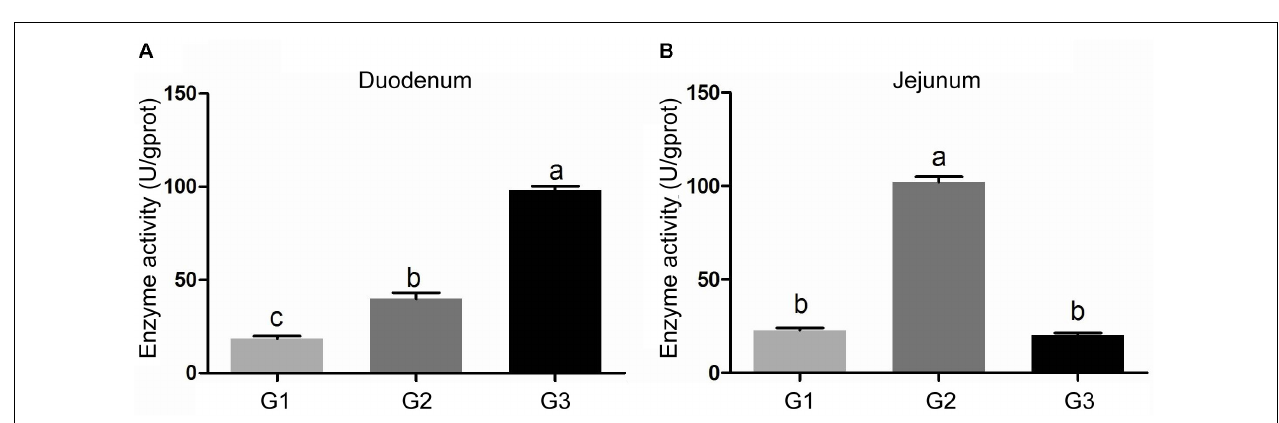
FIGURE 3 | Effects of Ba on activity of lipase in contents of duodenum (A) and jejunum (B) . Results were expressed as mean ± SEM, n = 6. a and b means significantly different ( p <